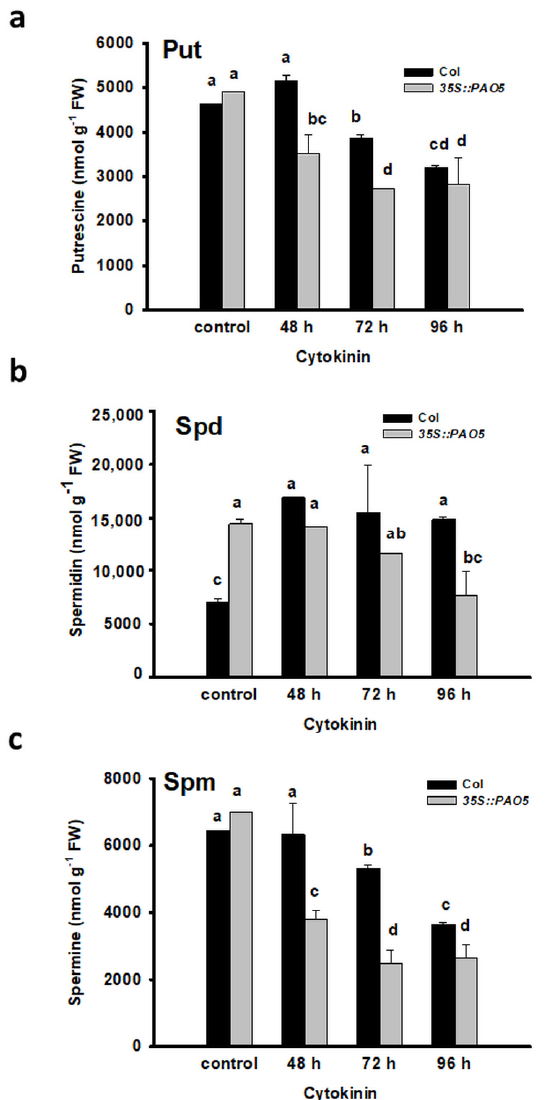
Figure 5. AtPAO5 overexpression influences the PA homeostasis in seedling roots before and during the conversion of lateral root primordia into shoots. Putrescine (Put) ( a ), spermidine (Spd) ( b ) and spermine (Spm) ( c ) contents were determined in 100 mg of root samples of wild type (Col) and transgenic (35S:PAO5) seedlings after 48, 72 and 96 h cytokinin treatment representing the organ conversion (48 h), the early (72 h) and late (96 h) shoot promeristem phases [7]. Data are means ± SE of three biological replicates with 20 technical replicates each. Different letters indicate significant differences of Duncan’s multiple comparisons ( p < 0.05).